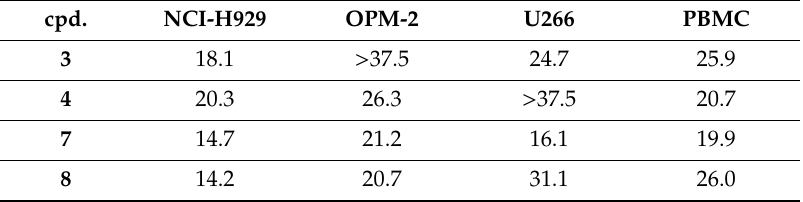
Table 4. IC 50 values of compounds 3 , 4 , 7 and 8 in µ g / mL after incubation for 24 h.